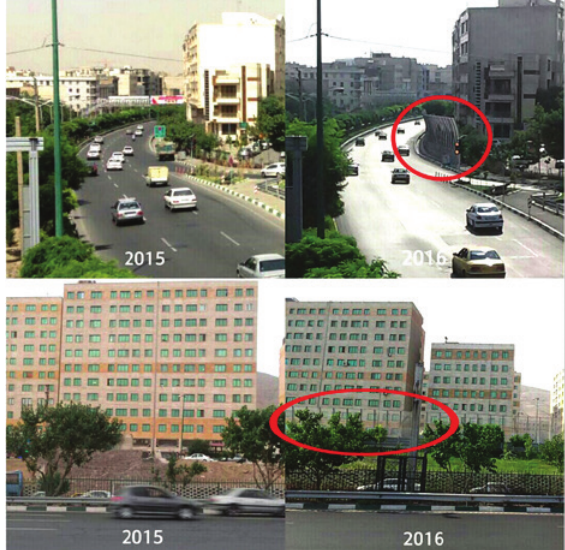
Figure 10. Before & after installation of noise barriers in some measurement points